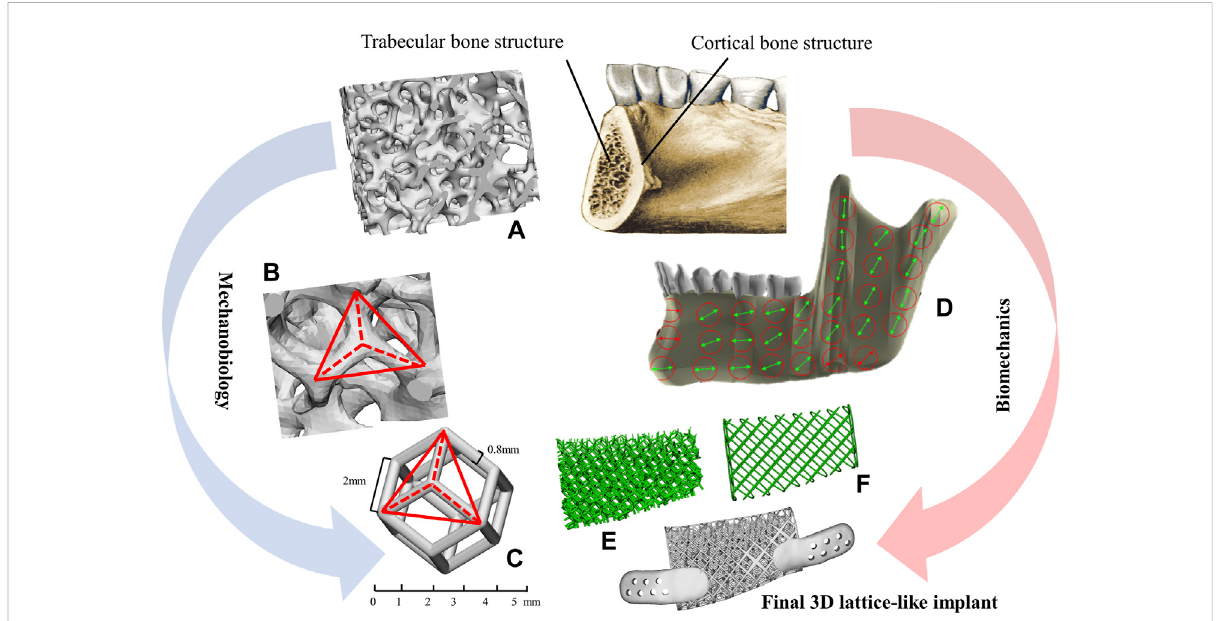
FIGURE 1 Methodological approach for the lattice-like implants. (A) The morphology of trabecular bone. (B) The texture characteristics of trabecular. (C) A dodecahedral cellular unit. (D) The overall view of local orientation of mandible and the arrow indicates the direction of maximum stiffness concerning the occlusal plane. (E) Trabecular-like component to mimic the cancellous bone of the mandible. (F) Grid-like component to mimic cortical bone of the